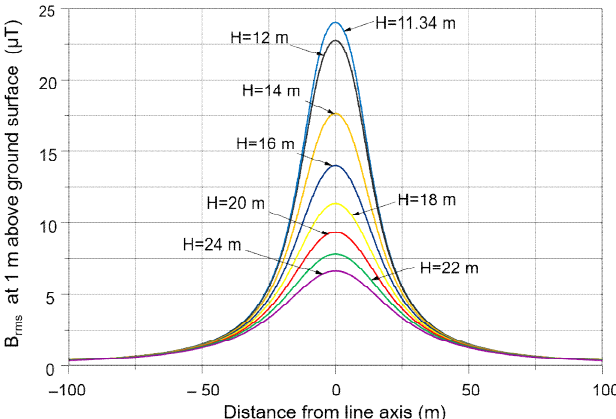
Figure 2. MF at 1 m above ground surface for various heights (H) for a three-phase line (based on [13], CIGRÉ 2009).